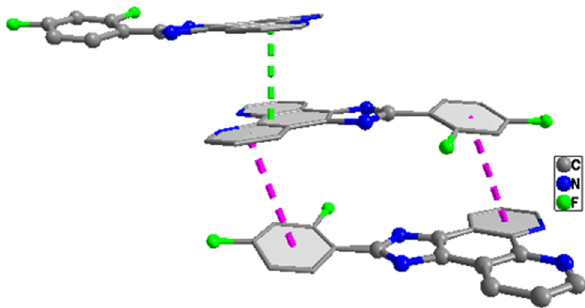
Figure 3: View of the π – π interactions between the two phen rings ( green dotted line ) and other π – π interactions between pyridine rings and benzene rings ( pink dotted line ) .